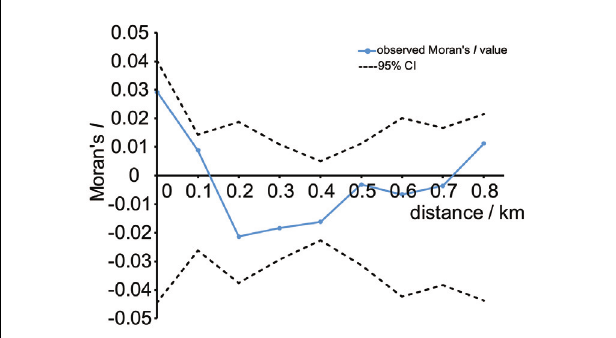
FIGURE 4 | Spatial autocorrelation analysis of genetic and geographical distance in M. micrantha using SPAGeDi. Dashed lines indicate 95% confidence intervals, assuming the null hypothesis that no autocorrelation exists, based on 9999 permutations.